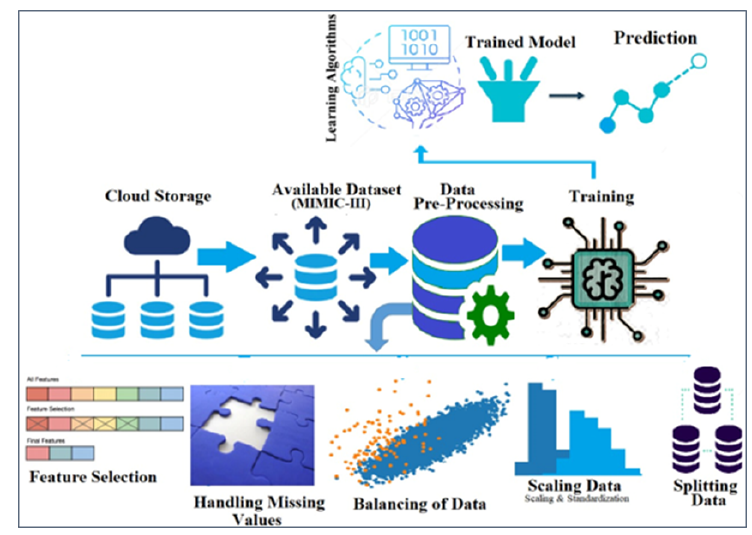
Figure 6. Architecture of the proposed